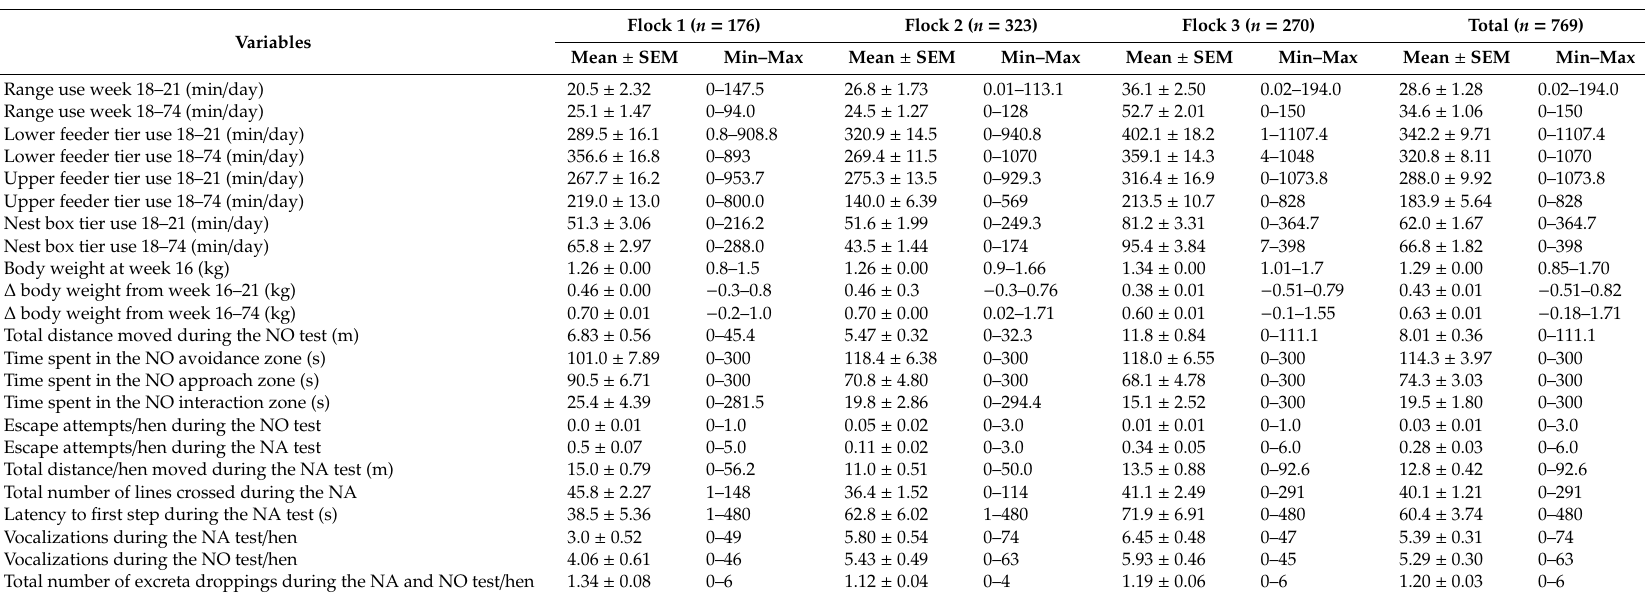
Table 3. Descriptive statistics (stayers and rangers combined) illustrating mean ± SEM, minimum and maximum values for all the variables obtained from individual hens across 3 flocks on a commercial free-range